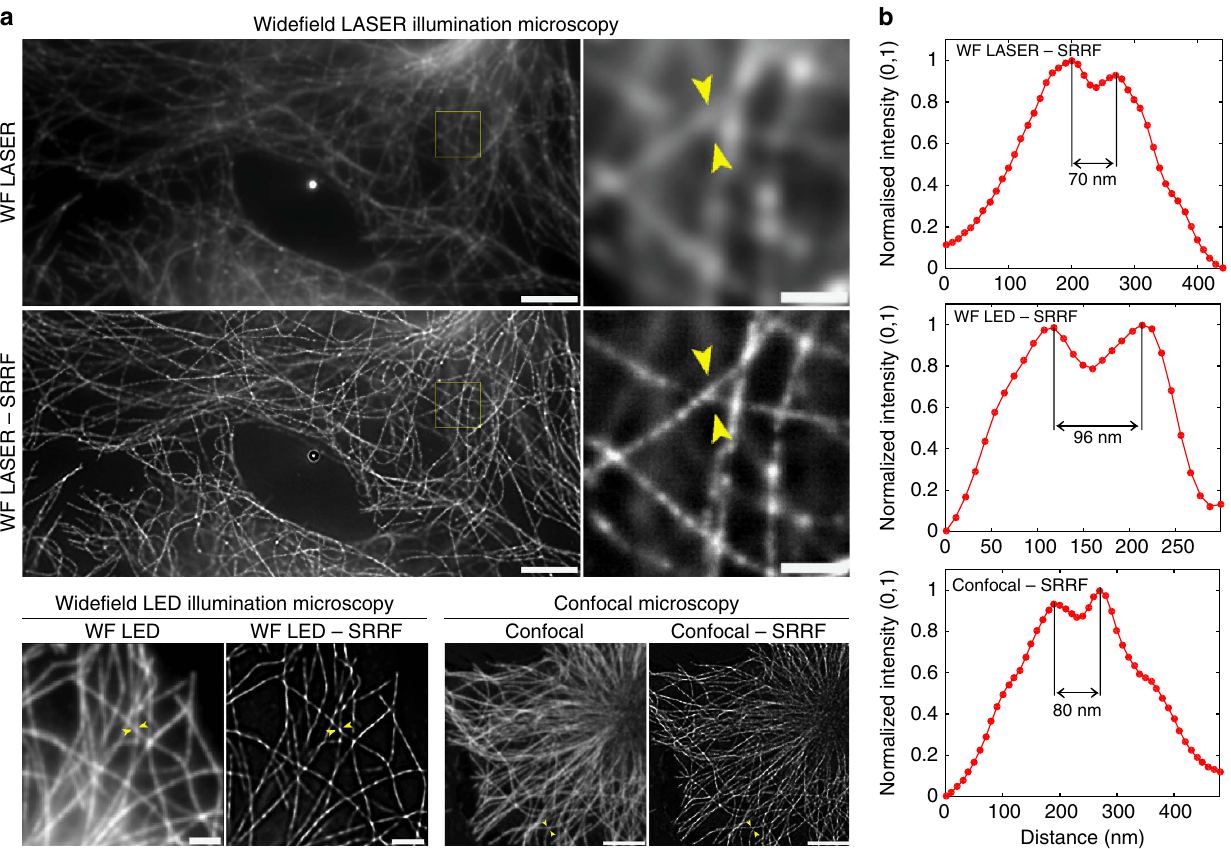
Figure 3 | SRRF applied to widefield laser and LED illumination microscopy and confocal microscopy. ( a ) Widefield laser-illuminated image and SRRF reconstruction of a fixed cell with Alexa Fluor 647-labelled microtubules following dSTORM acquisition (scale bar 5 m m) and expanded view of the yellow- boxed region (scale bar, 1 m m); widefield LED-illuminated image and SRRF reconstruction of Alexa Fluor 647-labelled microtubules (scale bar, 2 m m); confocal image and SRRF reconstruction of Alexa Fluor 647-labelled microtubules (scale bar, 5 m m). ( b ) Normalized line profiles taken from the regions between the yellow arrowheads for corresponding SRRF images in a showing separated